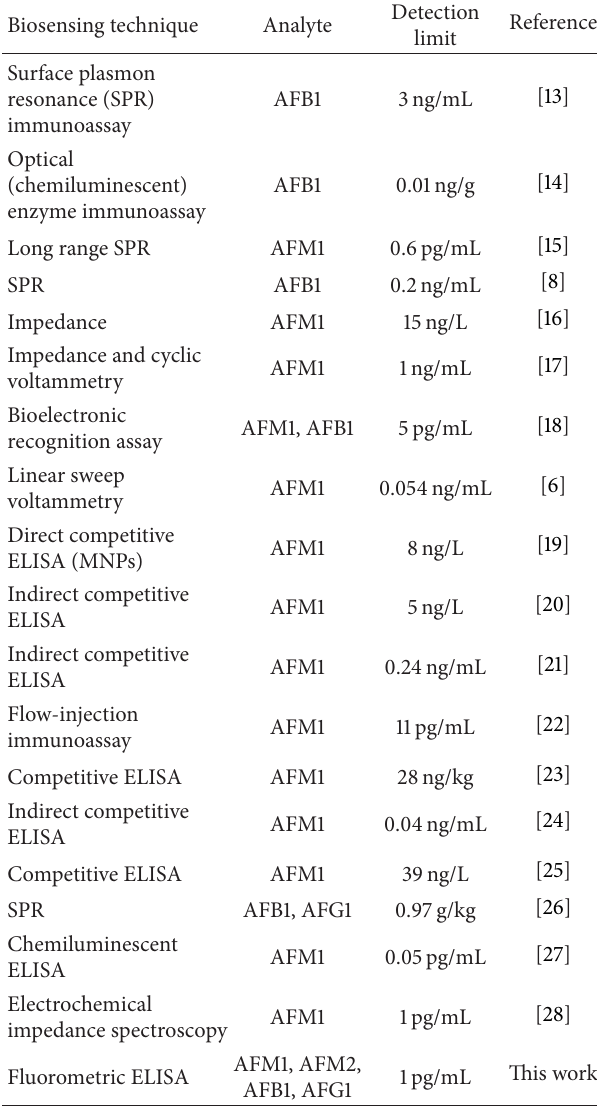
Table 1: Reported biosensing techniques for analysis of AFM1 and